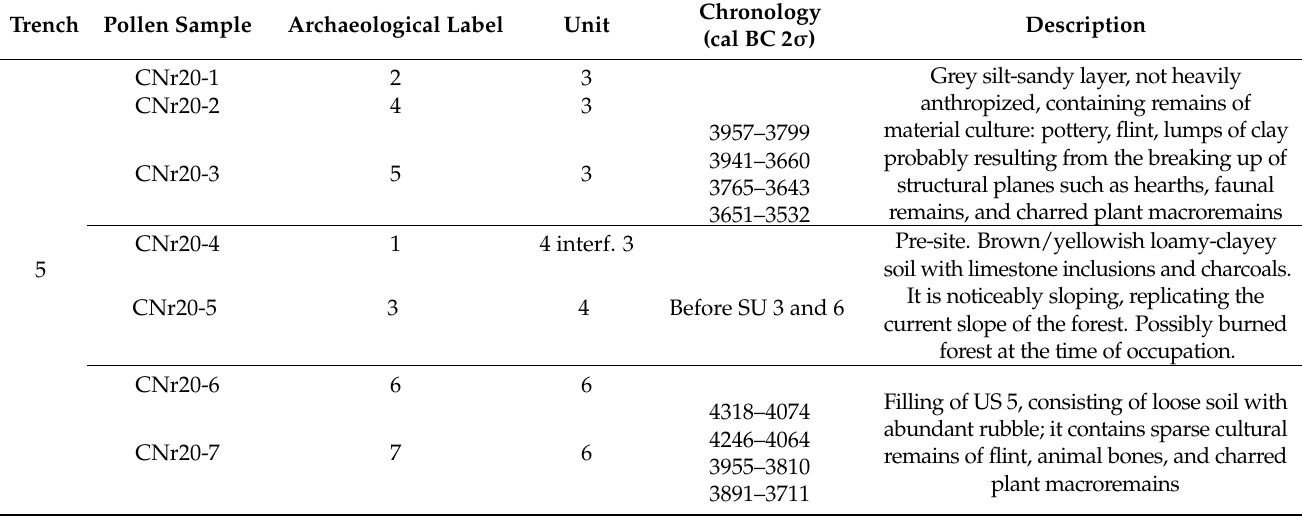
Table 1. Colombare di Negrar: List of pollen samples from the two trenches (5 and 4) excavated in the site (~4300–3500 cal